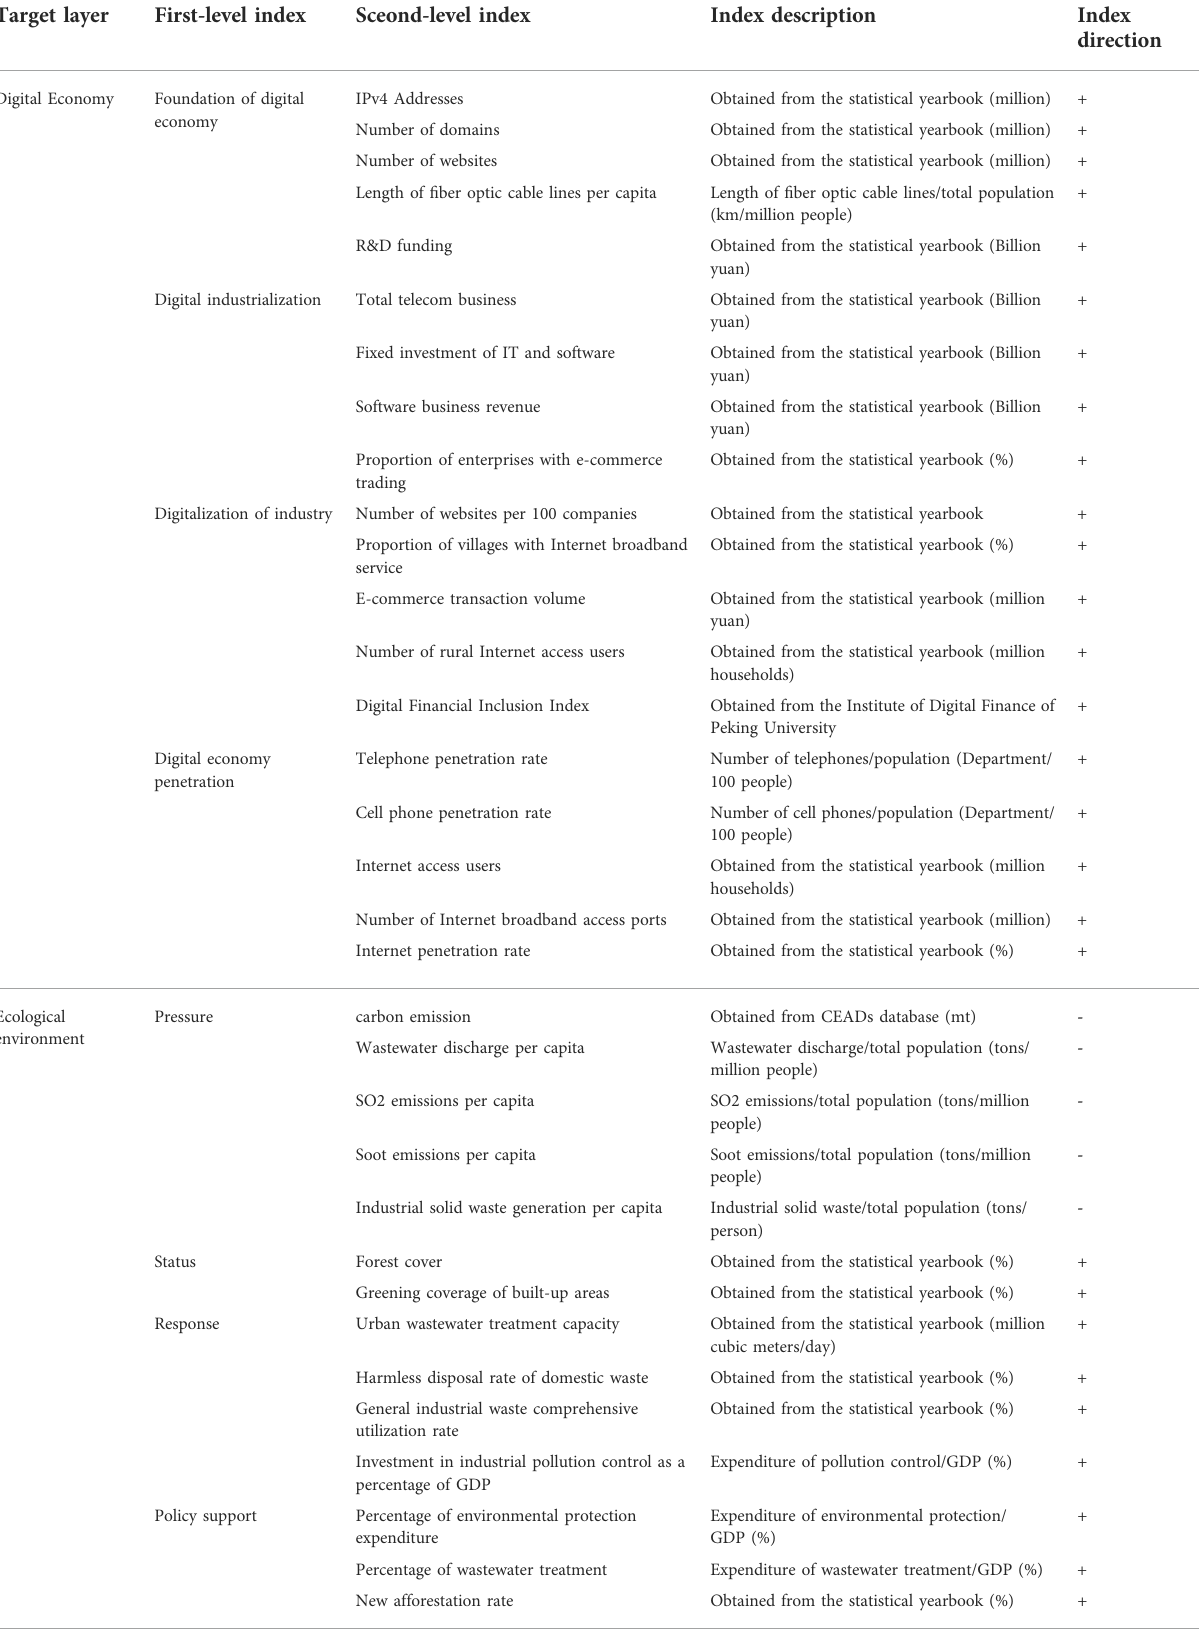
TABLE 1 Measurement system of the digital economy and ecological